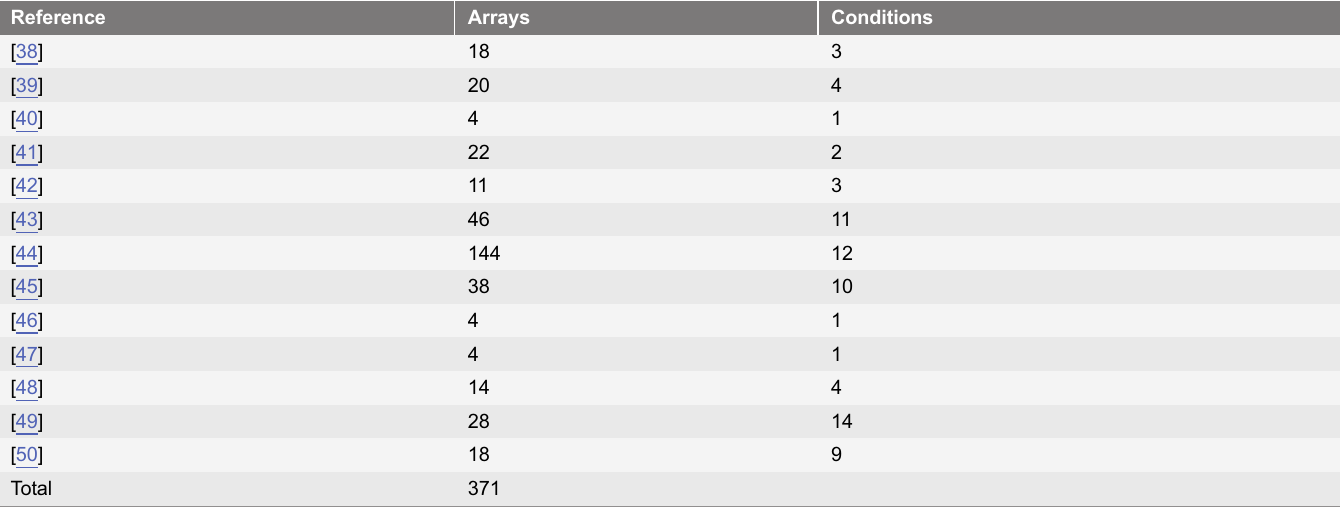
Table 1. References to the microarrays used in this